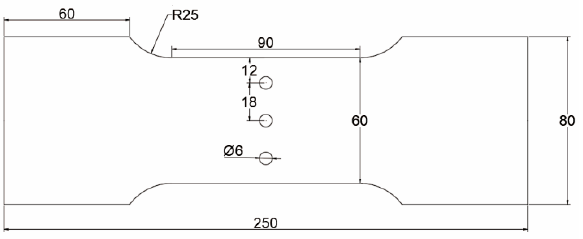
Figure 3. Three-hole cold-expanded aluminum alloy